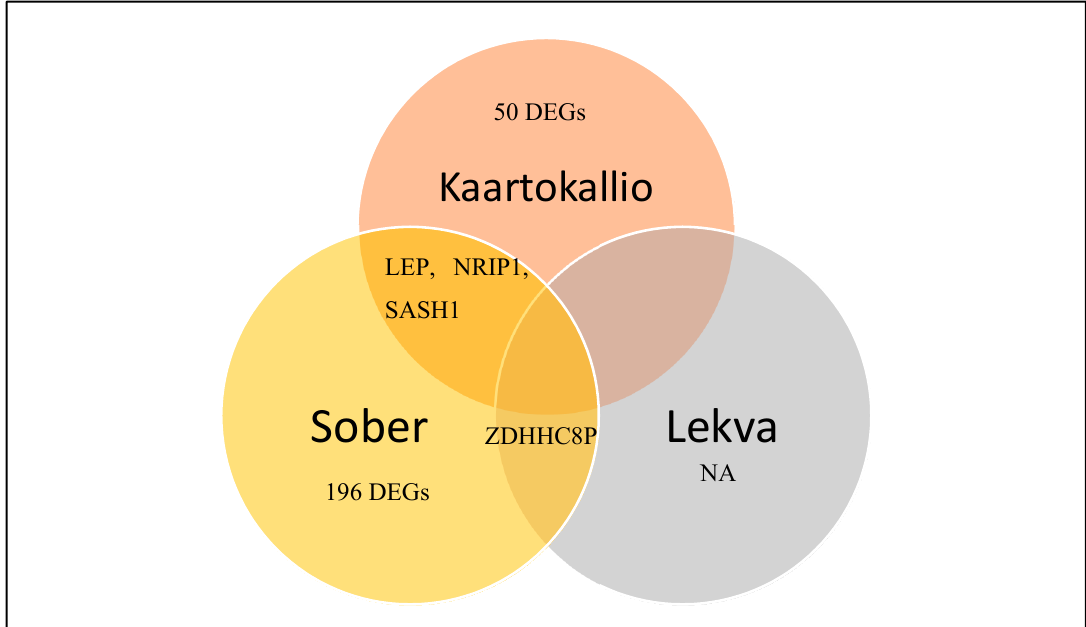
Figure 2. Identification of 250 commonly changed differentially expressed genes from three cohort profile datasets [6–8]. Different color areas represent different datasets. The overlapping areas mean the common differentially expressed genes. Statistically significant genes were defined with p < 0.05. (NA: Neuraminidase – unidentified gene). Table 2. The 250 differentially expressed genes (DEGs) were identified from three profile datasets, including 228 upregulated genes and 22 downregulated genes in the placenta tissue of preeclampsia compared to normal placenta tissues.